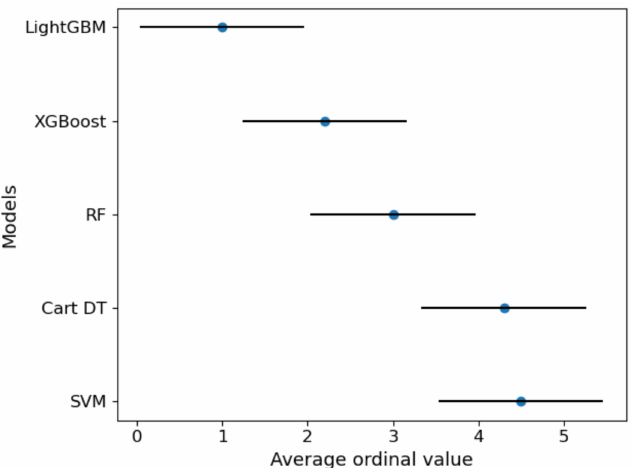
Figure 17. Friedman-Nemenyi test chart of 5 models under criterion MAE (CD = 1.928). The vertical axis in the figure shows each algorithm, and the horizontal axis is the average ordinal value. For each algorithm, a dot is used to display its average sequence value, and the horizontal line segment with the dot as the center represents the size of the critical value range. If the horizontal line segments of the algorithms overlap, it means that there is no significant difference between the two algorithms, otherwise, a significant difference